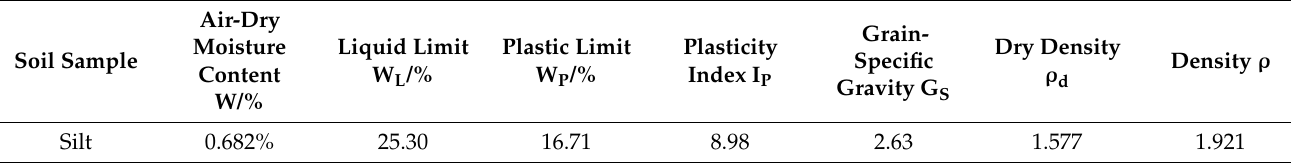
Table 1. Basic physical parameters of